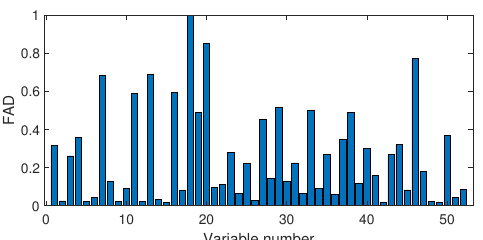
Figure 13. Fault isolation results for fault F10 based on distance correlation.